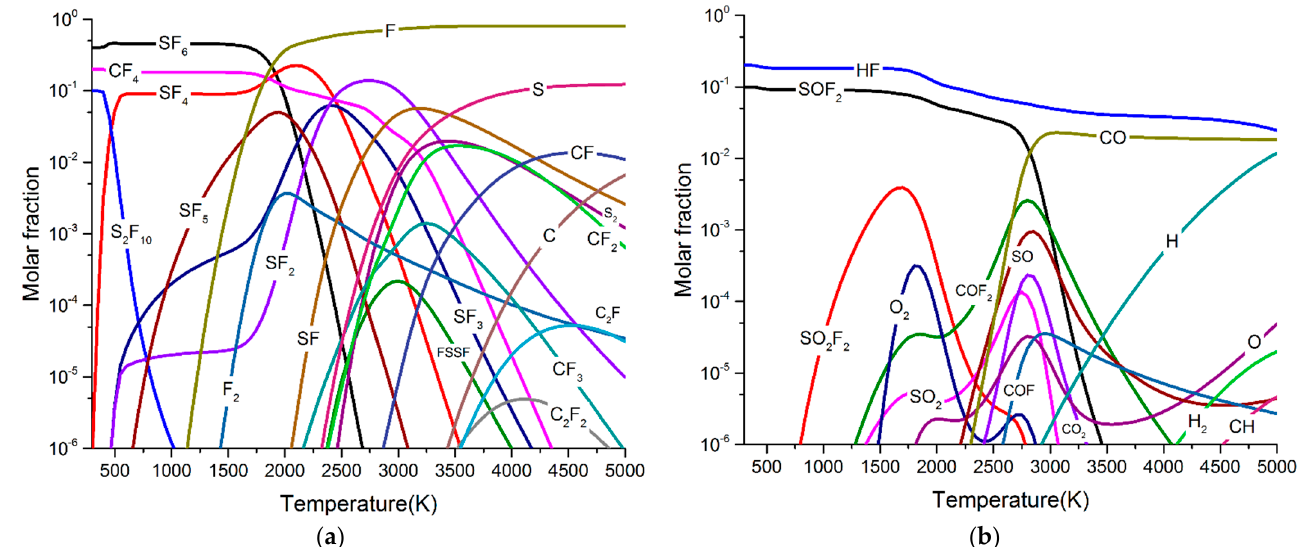
Figure 9. Particle composition of 70% SF 6 + 20% CF 2 + 10% H 2 O arc plasma at 0.6MPa. ( a ) SF 6 , SF 5 , SF 4 , SF 3 , SF 2 , SF, S, S 2 , F, F 2 , FSSF, S 2 F 10 , CF 4 , CF 3 , CF 2 , CF, C, C 2 F, and C 2 F 2 particles. ( b ) SOF 2 , SO 2 F 2 , COF 2 , COF, O 2 , O, SO 2 , SO, CO 2 , CO, HF, H, H 2 , and CH particles.